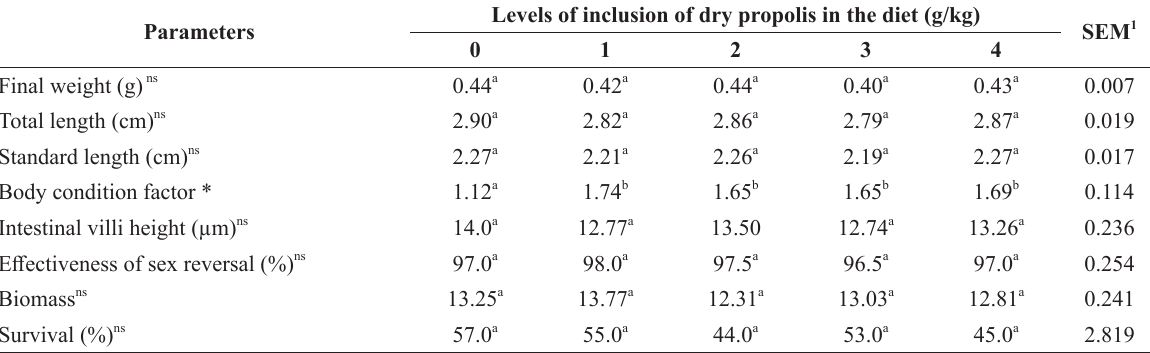
Parameters of production performance and intestinal villi height of Nile tilapia post-larvae fed with increasing levels of alcoholic extract of propolis in the diet. Levels of inclusion of dry propolis in the diet (g/kg) Parameters